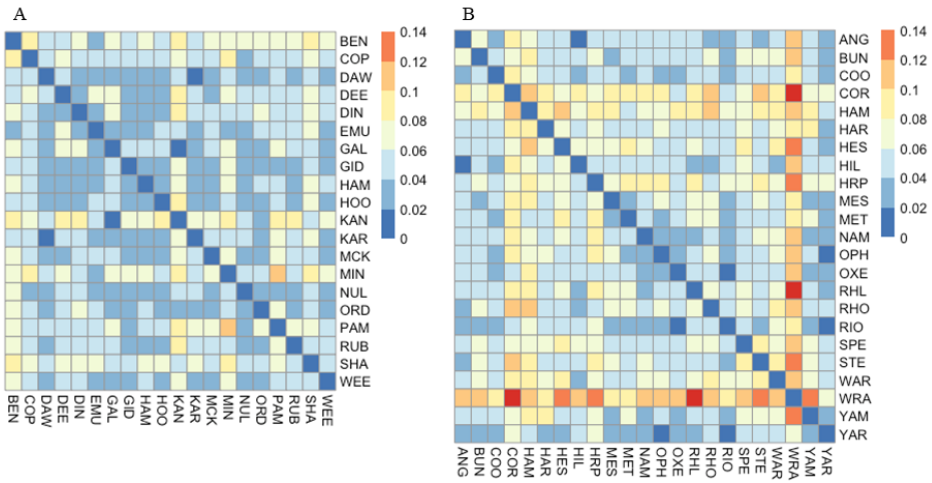
Figure 3. Heatmaps displaying pairwise population F ST values (see legend) based on nuclear microsatellite data for ( A ) C. hamersleyana and ( B ) A. pruinocarpa.